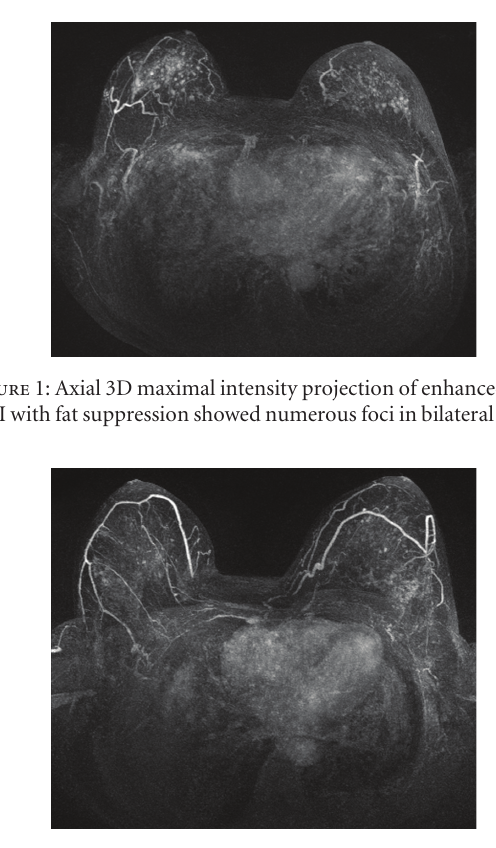
Figure 2: Axial 3D maximal intensity projection of enhanced breast MRI with fat suppression shows di ff use nonmass infiltrating enhancement symmetrically in bilateral breast